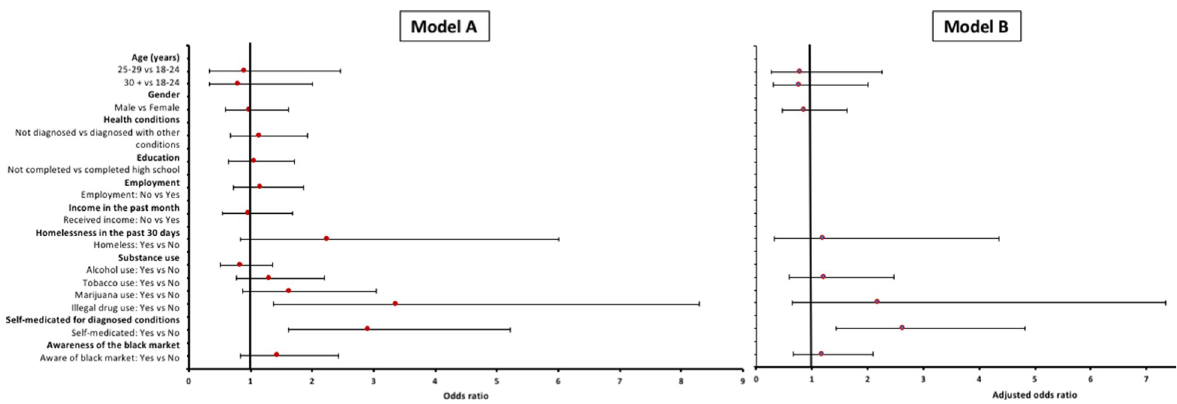
Fig 4. Odds ratios showing the effect of each variable on misuse among PLWH in the eThekwini district. Model A represent the odds ratios showing the association of each variable on misuse among PLWH in the eThekwini district. All variables were fitted in the model, including geographical setting, to assess their collective association on the outcome for Model B. Model B represents adjusted odds ratios showing the association of a group of variables on misuse among PLWH in the eThekwini district.